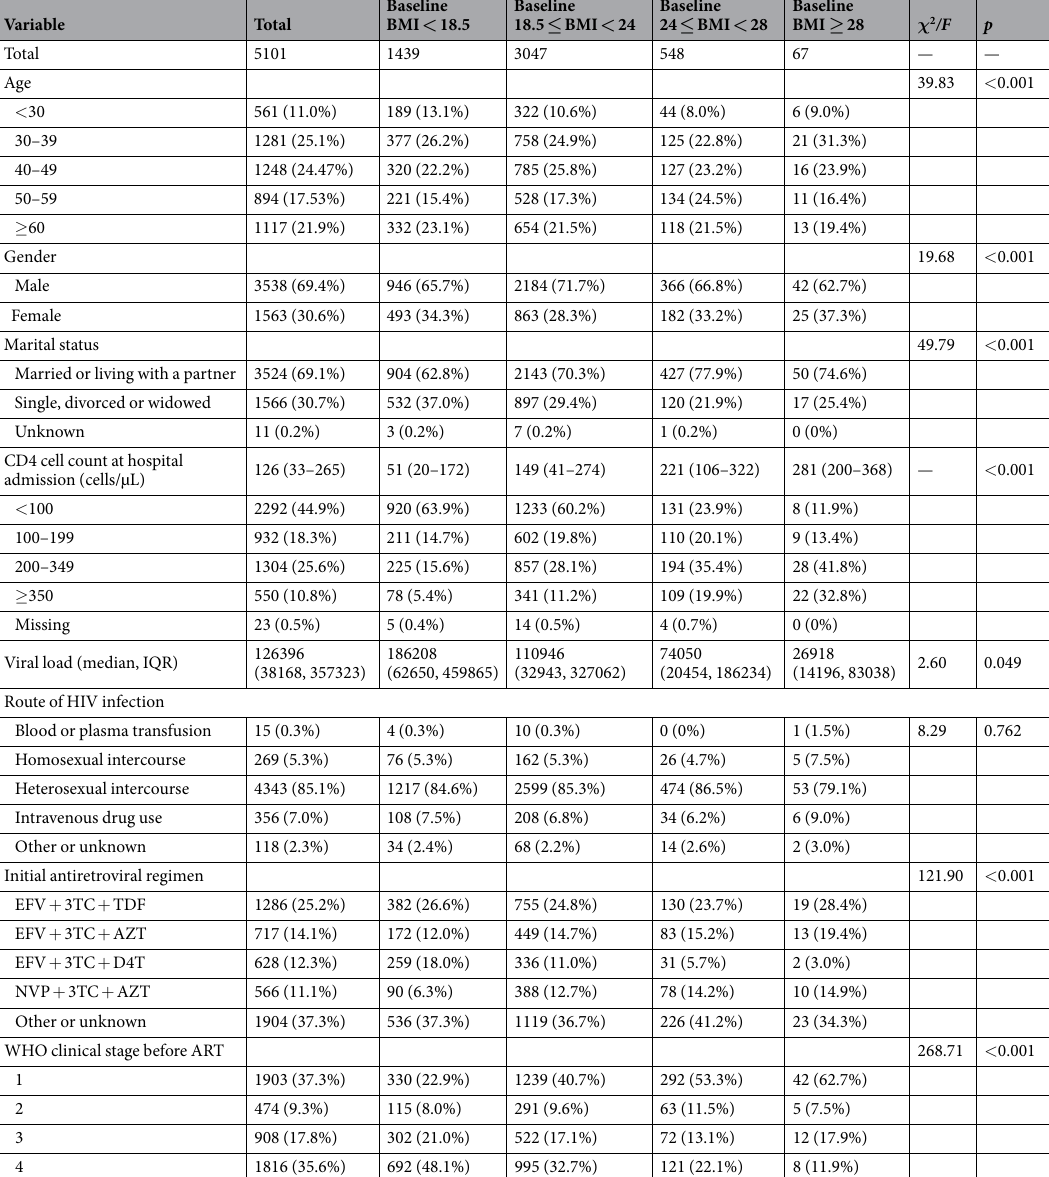
Table 1. Characteristics of patients with HIV infection at ART initiation. The data are the medians (IQRs) or n (%). Age, gender, marital status, CD4 T cell count, viral load regimen, and WHO clinical stage before ART were significantly associated in different BMI groups (p < 0.05). AZT = zidovudine. 3TC =